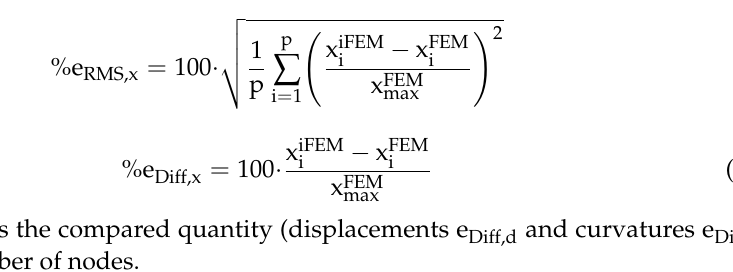
Figure 4. 1st order element with three station points. The comparisons between both the vertical displacements and the corresponding curvatures obtained using the direct FEM (red points) and iFEM (blue line) analyses are reported in Figure 5. According to the previous works with linear elastic elements [14,15], the two sets of outputs are in good agreement. These results are due to the small nonline- arities present along the element given by the concrete cracking in a limited portion across the beam, which is characterized by an average behavior between the 1st and 2nd phase. Indeed, from Figure 5, the difference between cracked and uncracked stage (1st and 2nd phases, respectively) is not visible due to the structural response of such a kind of rein- forced concrete beam. The RMS percent error is 0.053% for the displacements and 0.036% for the curvatures. ( a ) ( b ) Figure 5. Comparison between direct finite element method (FEM) and inverse finite element method (iFEM) solutions in terms of ( a ) displacements diagram; ( b ) curvature diagrams. Increasing the load up to q 2 = 180 KN/m, a maximum bending moment of approxi- mately 97% of the ultimate bending moment (M u = 5208 KN·m) is produced (Figure 3). In this case, in a zone of about 3 m across the midspan of the beam, the acting bending mo- ment exceeds the yielding bending moment, as reported in Figure 6.